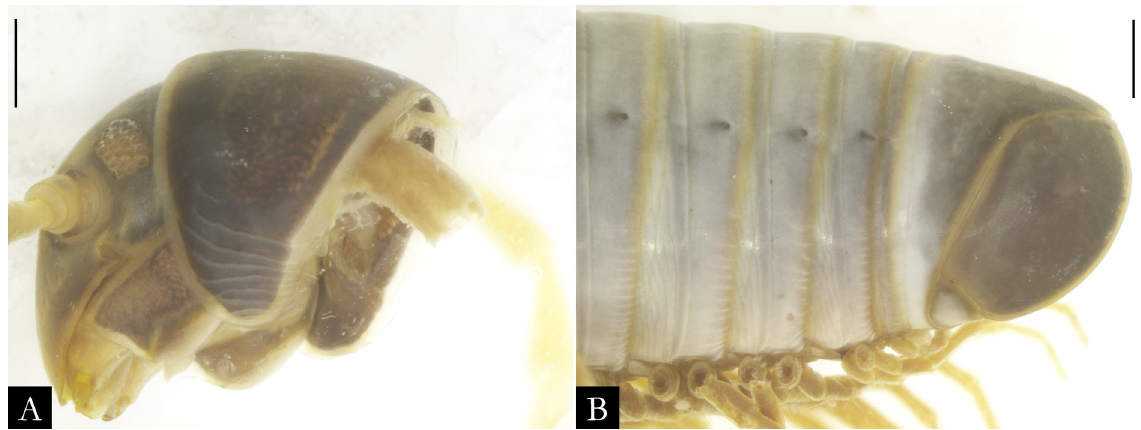
Fig. 48. Pseudonannolene anapophysis Fontanetti, 1996, ♂ (IBSP 5209), in lateral view. A . Anterior region. B . Posterior region. Scale bars = 1